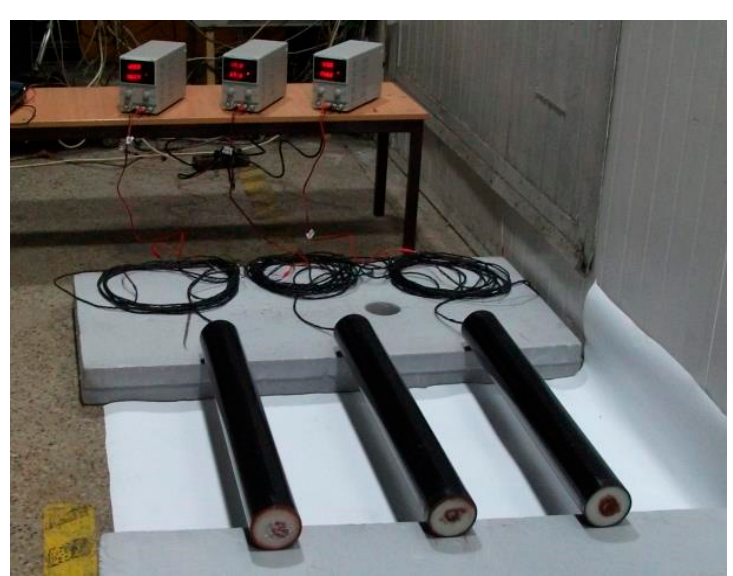
Figure 4. Electric heater during the tests.